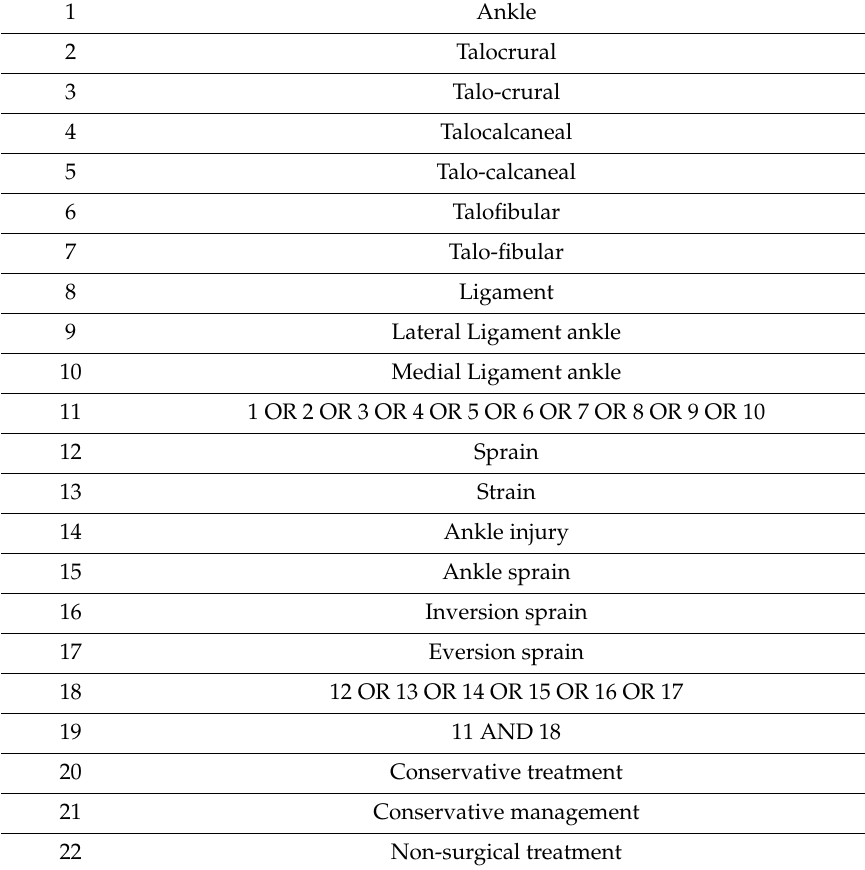
Table A1. PubMed. Total articles: